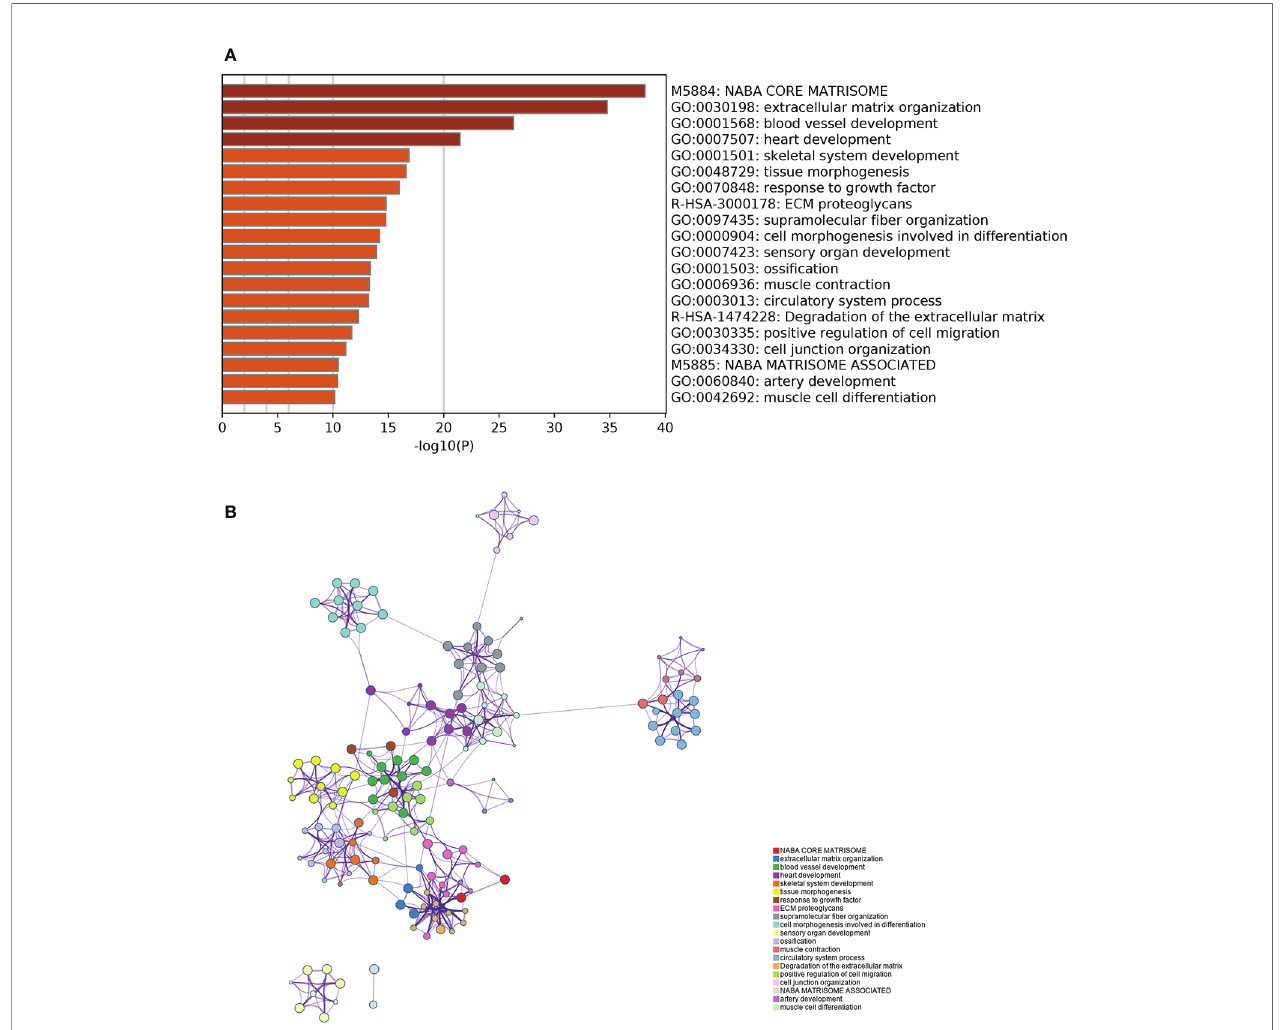
FIGURE 5 | Gene Ontology enrichment analysis of the key gene module. (A) The top 20 GO terms which were signi fi cantly enriched. (B) The interrelationship and intrarelationship among the cluster of enriched terms. Each dot represents one term, and the color annotates its cluster